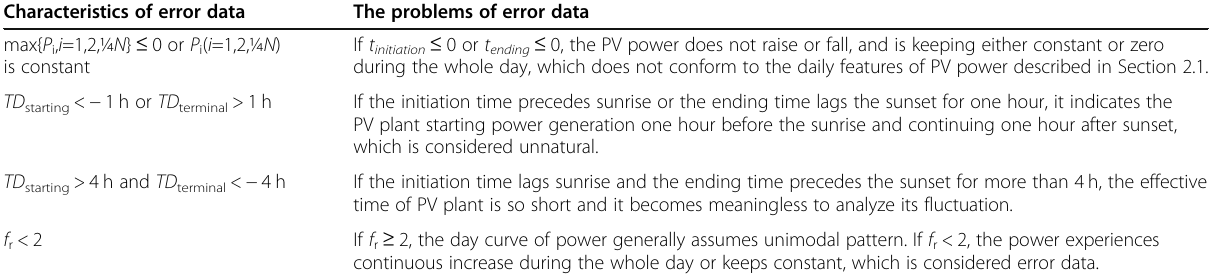
Table 1 The features of indices for error data Characteristics of error data The problems of error data